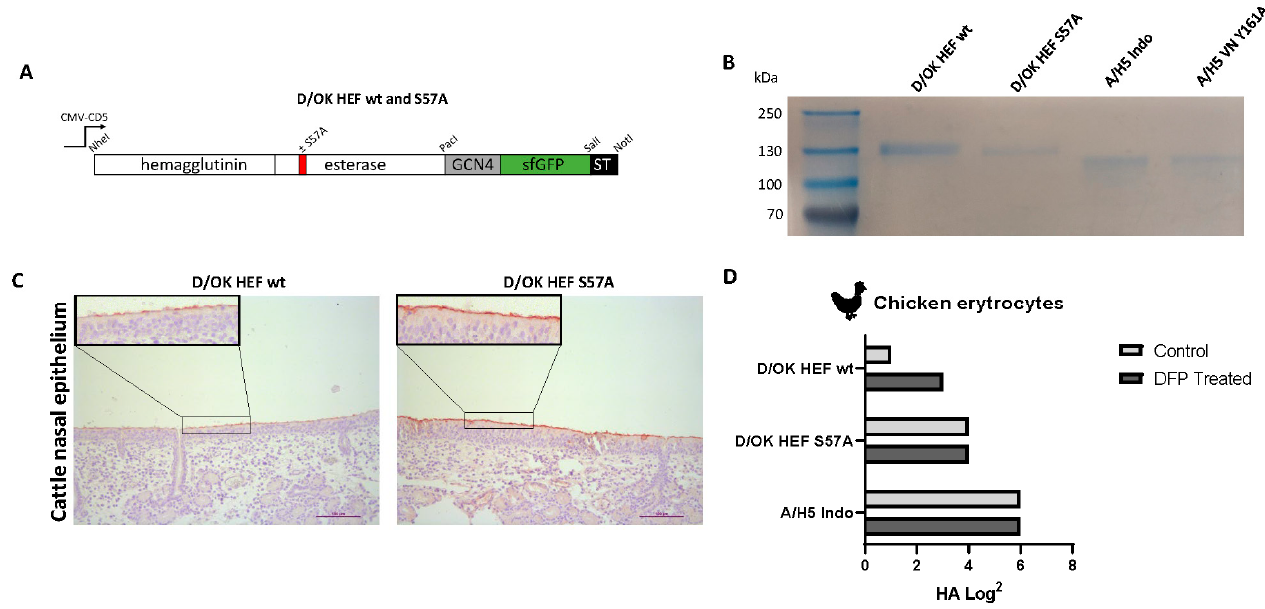
Figure 1. ( A ) Schematic overview of the expression plasmid used for the production of the HEF protein in a mammalian cell culture system. The ORF is controlled by a cytomegalovirus (CMV) promoter with a CD5 signal peptide for excretion of the HEF protein from the cell into the supernatant. To create D/OK HEF S57A, a single point mutation at amino acid 57 was switched from serine to alanine to knock out esterase activity. ( B ) Coomassie staining of the purified HEF proteins D/OK HEF wt and D/OK HEF S57A, and HA control proteins A/H5 Indo and A/H5 VN Y161A. ( C ) Protein histochemical staining of cattle nasal epithelium to compare protein binding between wildtype D/OK HEF wt and esterase knockout mutant D/OK HEF S57A. Scale bars are 100 µm ( D ) Hemagglutination assay for comparing protein binding avidity using chicken erythrocytes between wildtype D/OK HEF wt and esterase knockout D/OK HEF S57A. The chemical inhibitor diisopropyl fluorophosphate (DFP) was used to directly inhibit esterase activity. The HA protein A/H5 Indo was used as a negative control for its lack of esterase activity.